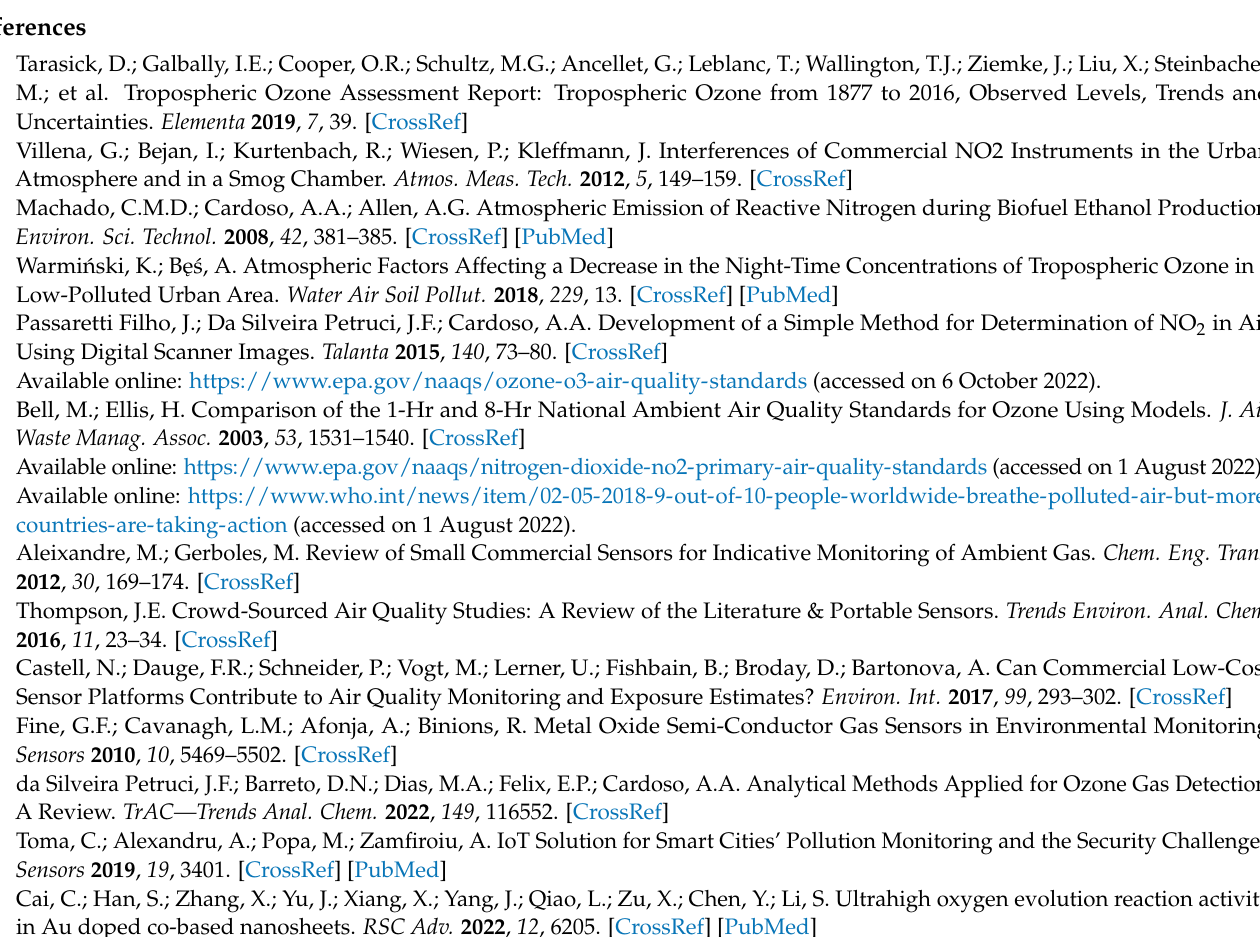
Figure S3: Analytical curve of absorbance versus indigotrissulfonate (a) and nitrite (b) concentrations built using the developed detection